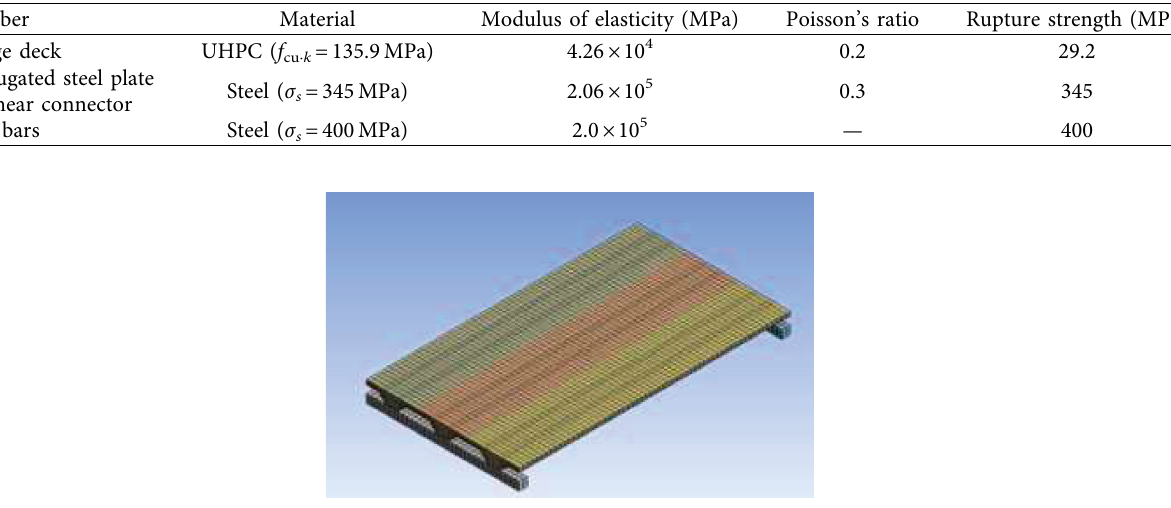
Figure 5: 3-D finite element model in ANSYS Workbench